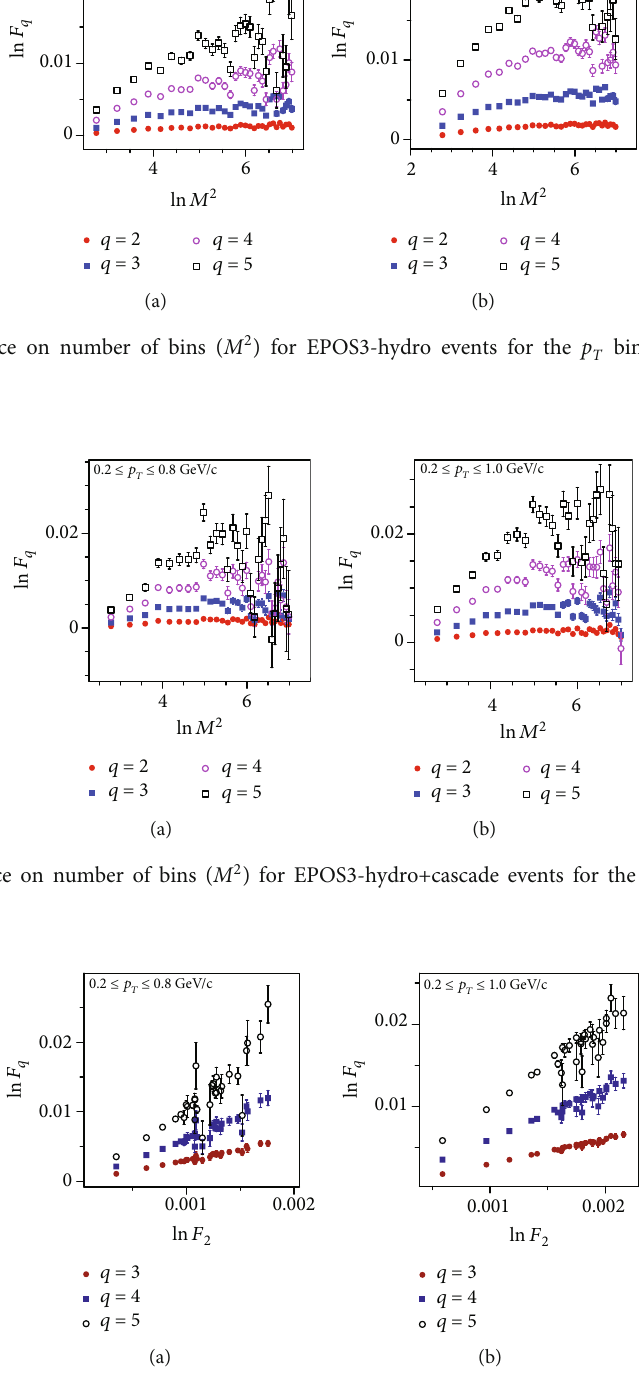
p 0 : 2 ≤ p ≤ 0 : 8 GeV/ c and 0 : 2 ≤ p T bins T